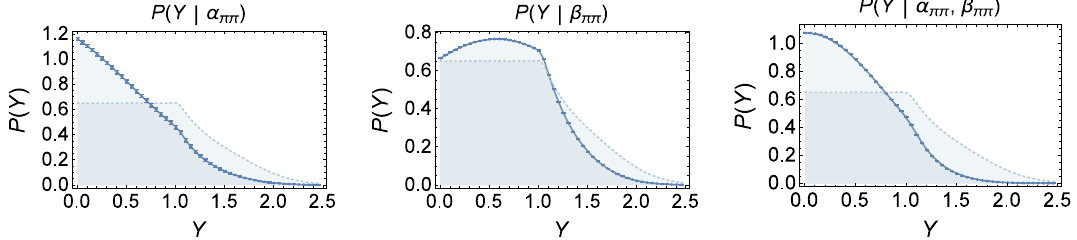
Fig. 5 Probability densities in comparison with the prior (transparent). ππ scattering data. Smoothed. Error bars estimate the precision of the Monte Carlo integration